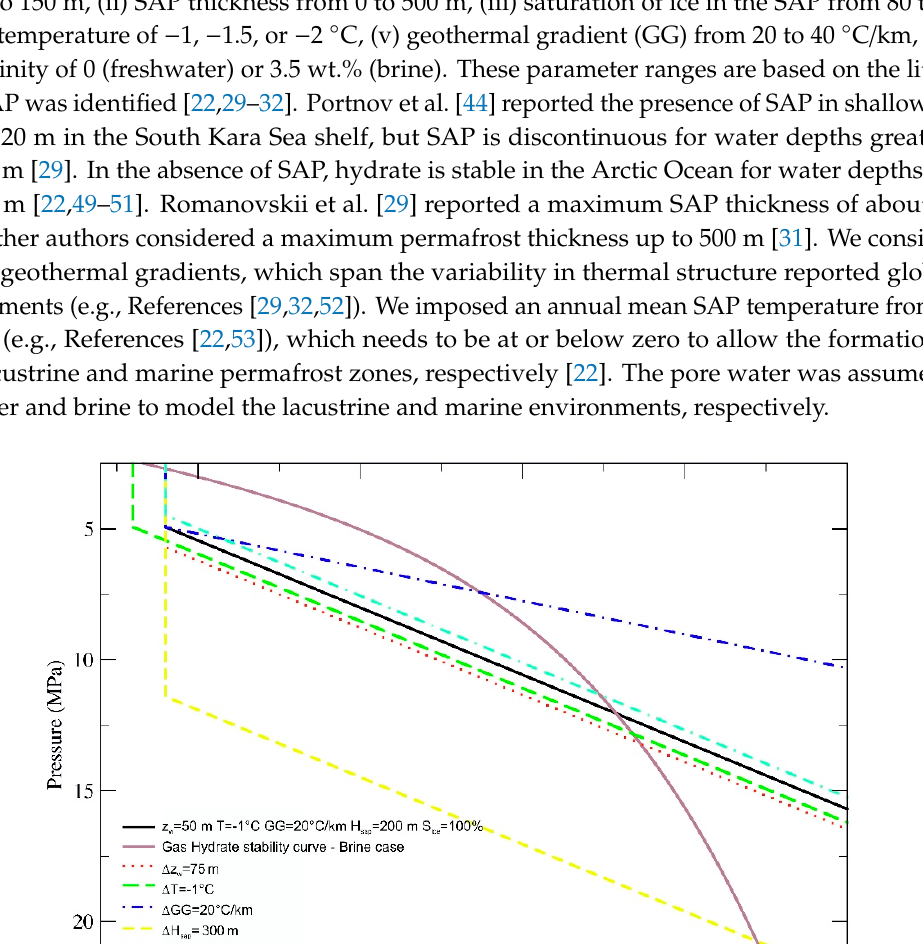
. Figure 2. P GHSZ versus P SAP for freshwater and brine cases. In each panel, one parameter is changed, while the others are fixed. 3. Results The curves in Figure 2 summarize the results of our empirical approach. As can be observed in Tables 1 and 2, the parameter a3 is generally low, indicating a linear relationship between the pressure at the base of SAP and the pressure at the base of the GHSZ. Comparing the results obtained in the freshwater and brine cases, we deduced that a1 was higher for the freshwater case. This trend